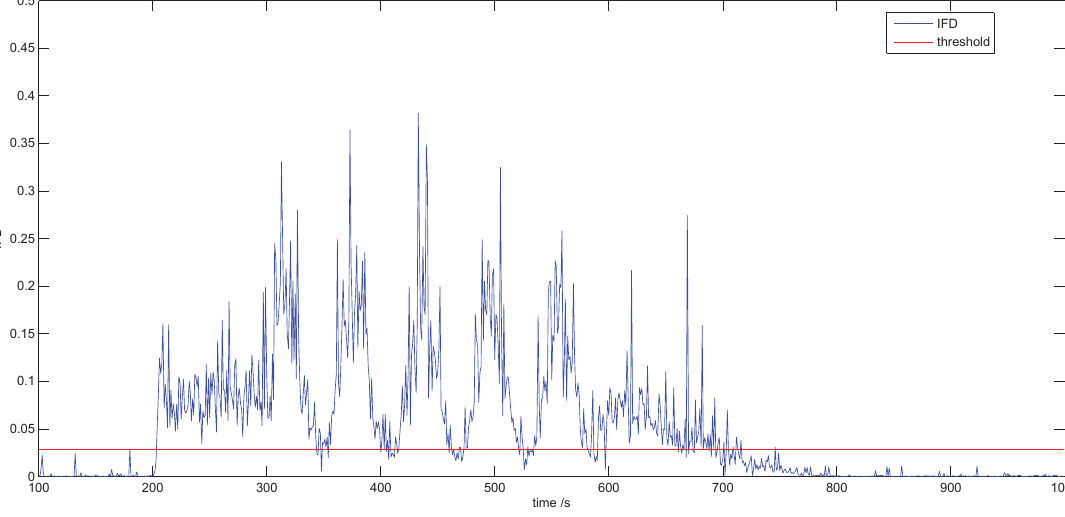
Figure 10. Results of fault detection. IFD, indicator of fault